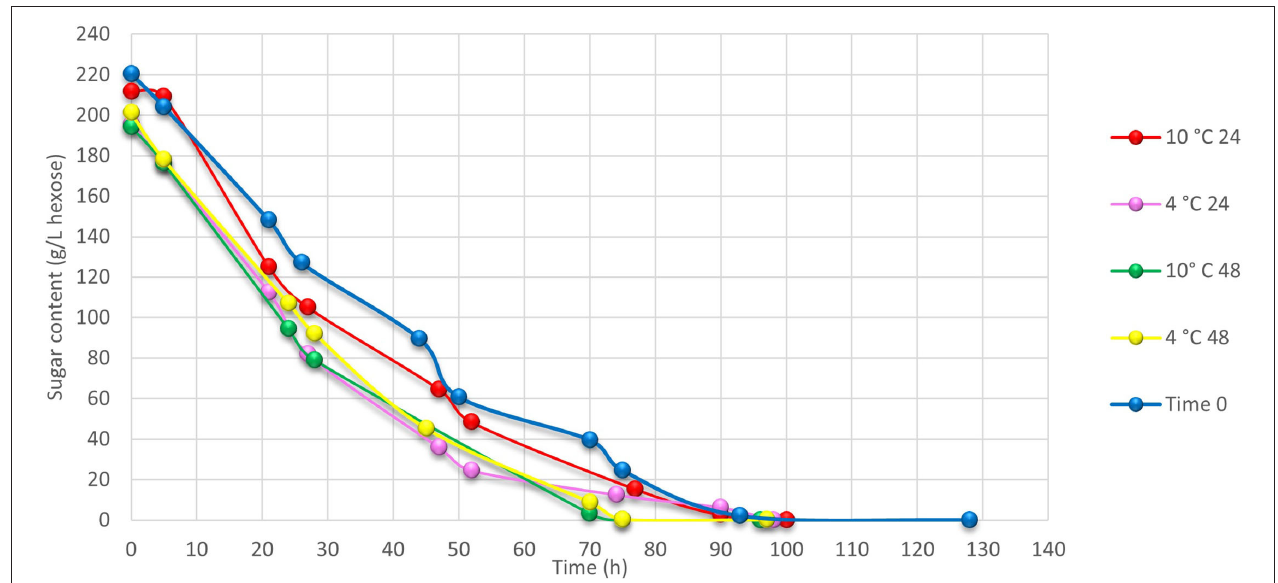
FIGURE 4 | Changes of sugar content during alcoholic fermentation process in grape samples kept at 4 or 10 ◦ C per 24 and 48h and at harvest (T0).